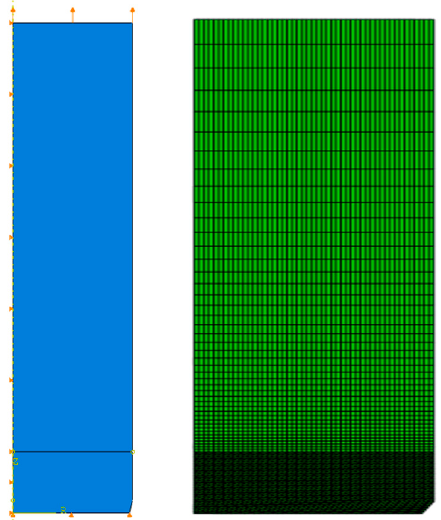
Energies 2020 , 13 , x FOR PEER REVIEW Figure 1. Geometry, boundary conditions and discretization of the specimen. Figure 1. Geometry, boundary conditions and discretization of the specimen.